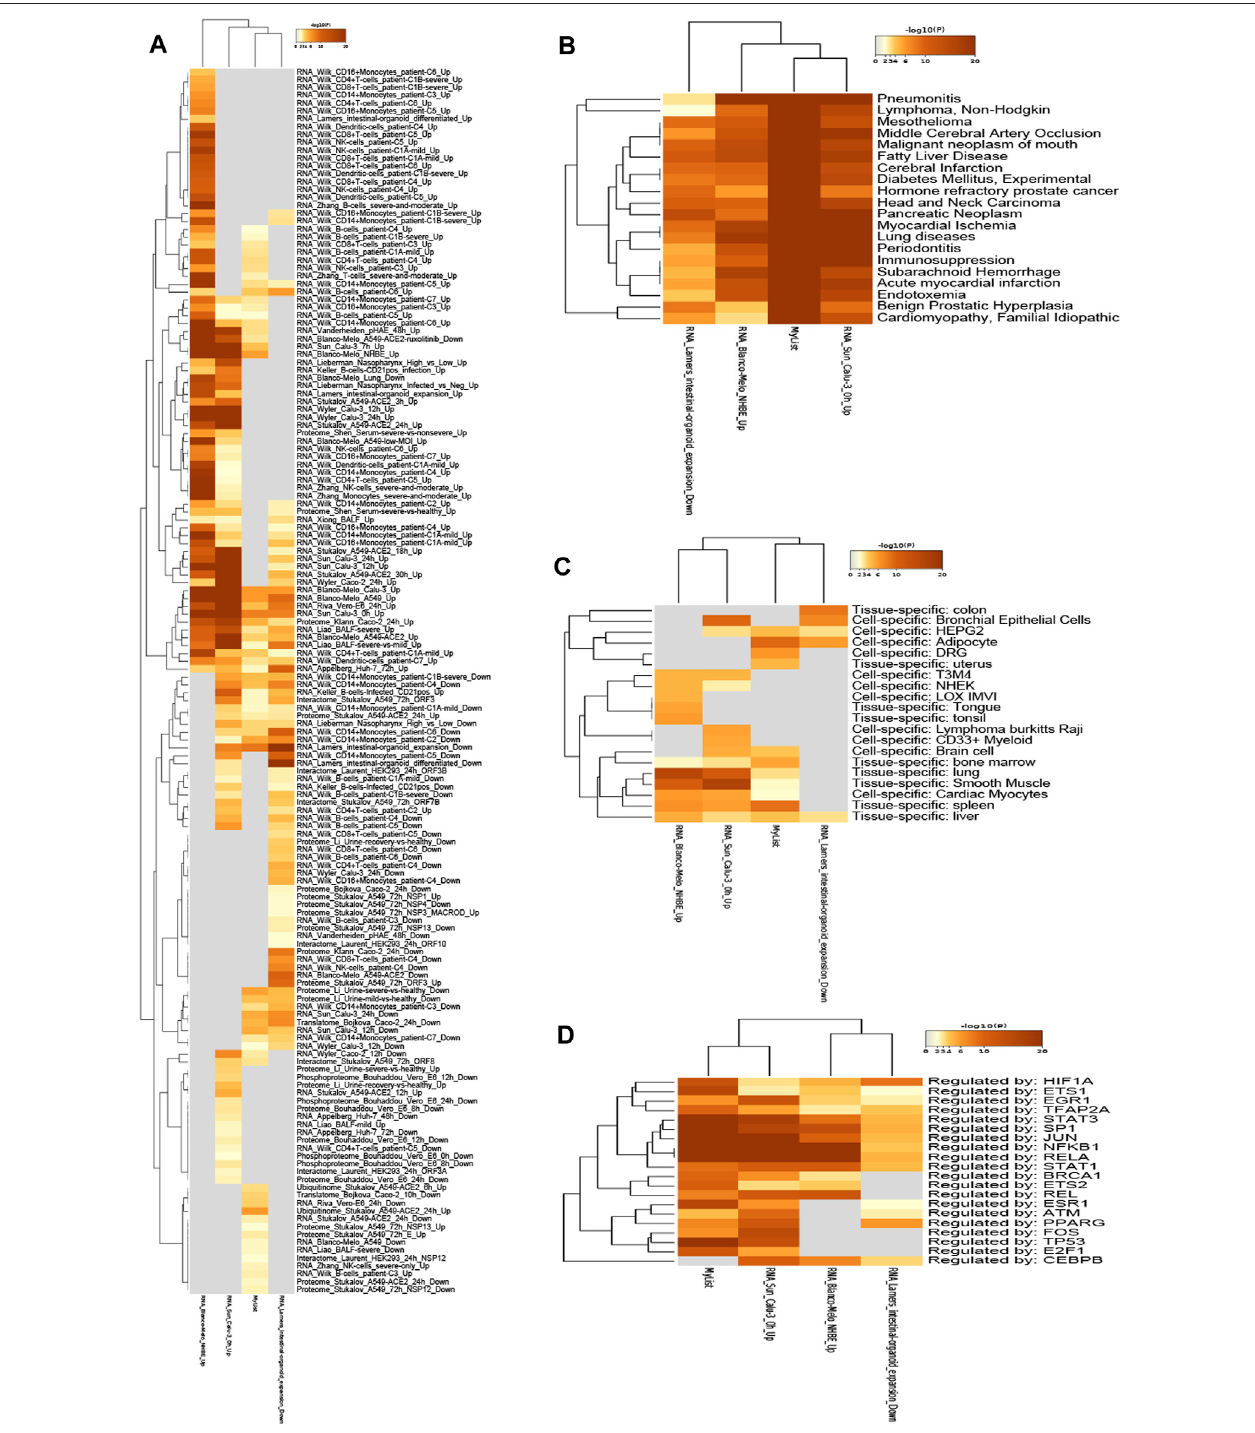
FIGURE5| Heatmapof192genesenrichmentsareidenti fi edinthefollowingontologycategories:COVID,DisGeNET,PaGenBase,TRRUST,coloredby p -values. The darker the color, the higher the ranking. (A) Enrichment analysis result in COVID. (B) Enrichment analysis result in DisGeNet. (C) Enrichment analysis result in PaGenBase. (D) Enrichment analysis result in TRRUST.